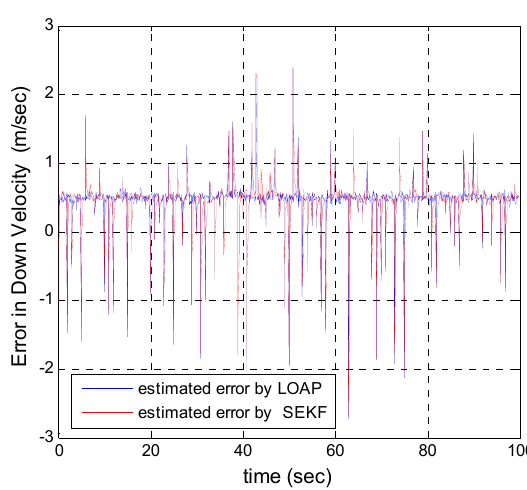
Figure 9. Error estimation of height.